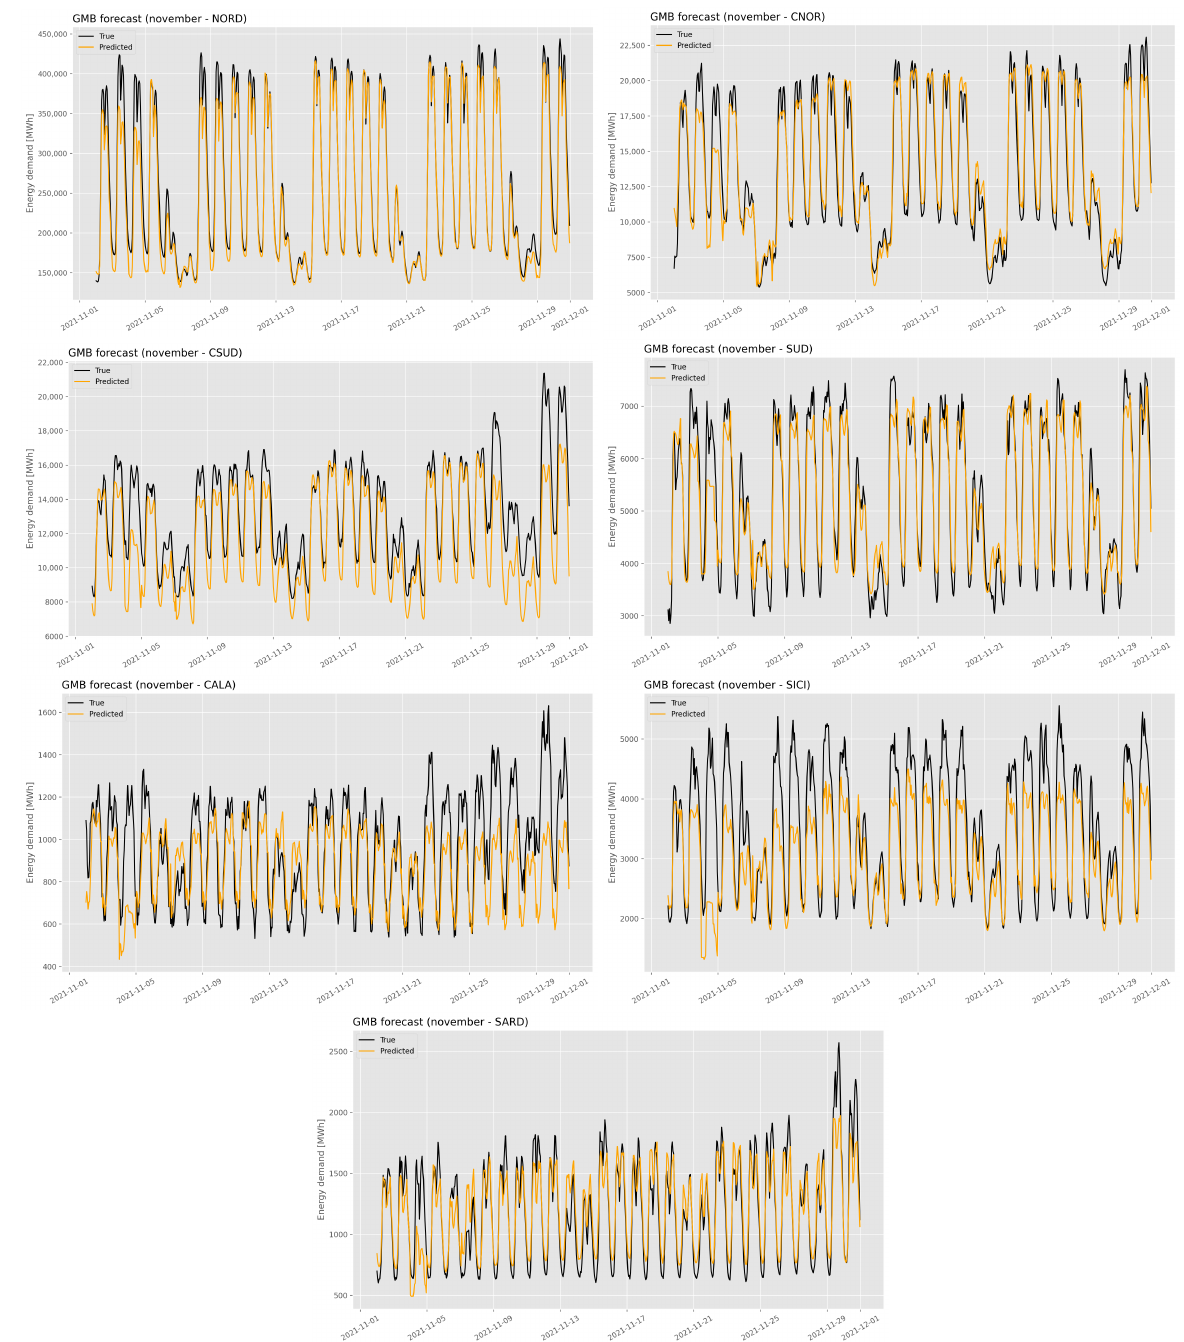
Figure 7. Prediction of GBM model for November